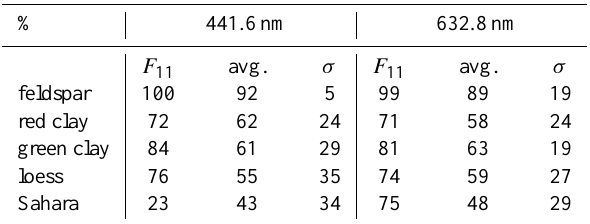
Table 2. Percentages of spheroid coverages for different samples.